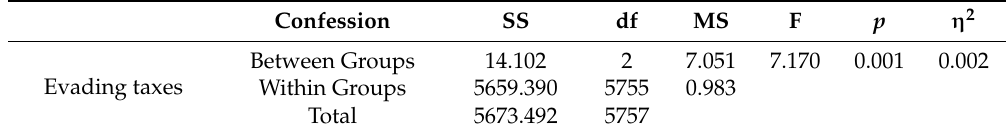
Table A5. Evading taxes among